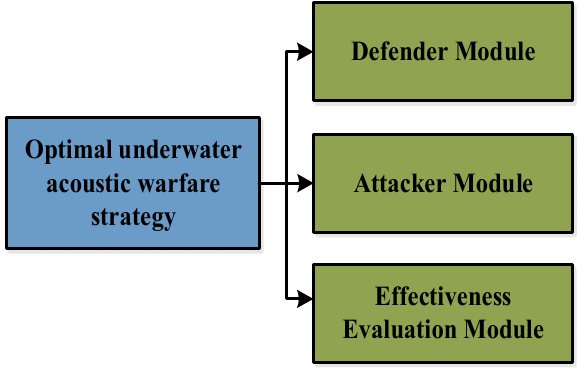
Figure 7. The optimal underwater acoustic warfare strategy development method.